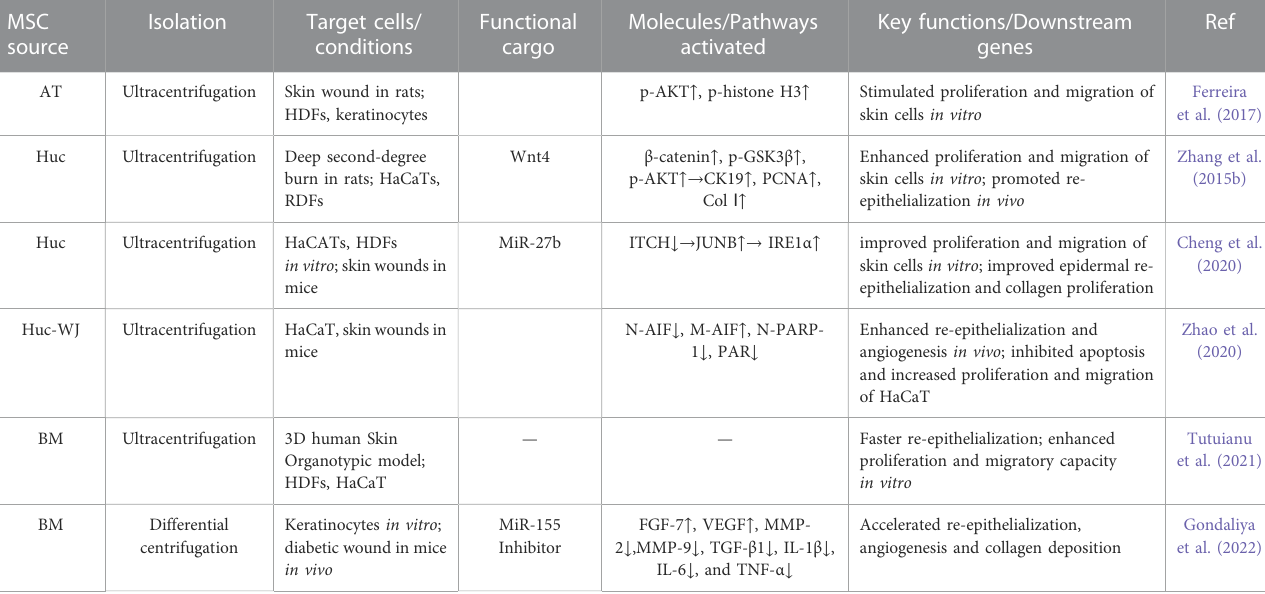
TABLE 5 MSC-sEVs exert therapeutic effects in boosting re-epithelialization during wound healing. MSC